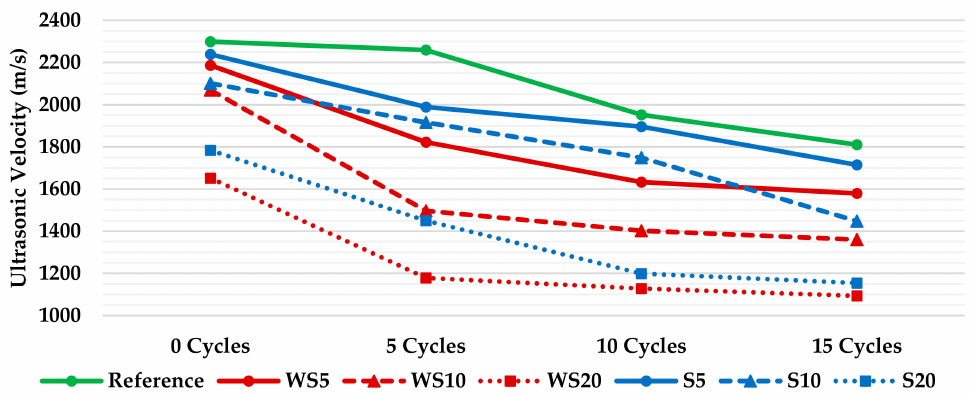
Figure 12. Ultrasonic velocity of the plasters after 0, 5, 10, and 15 wetting–drying